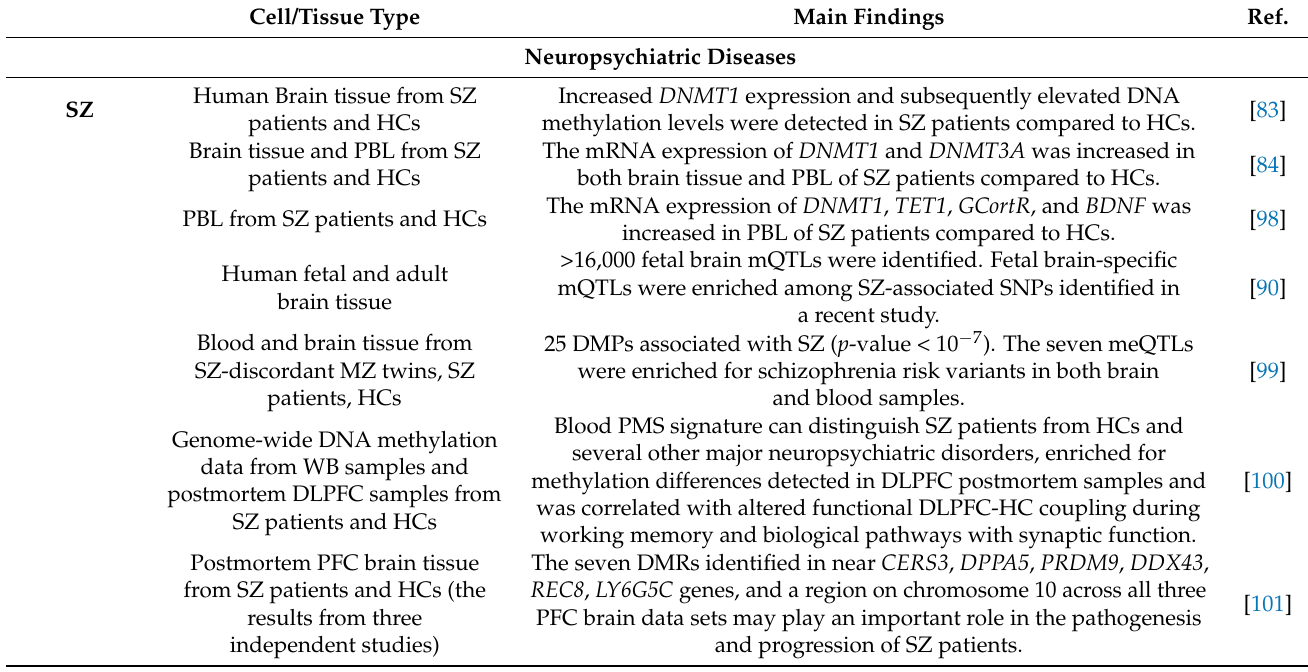
Table 3. Potential DNA methylation markers in neuropsychiatric